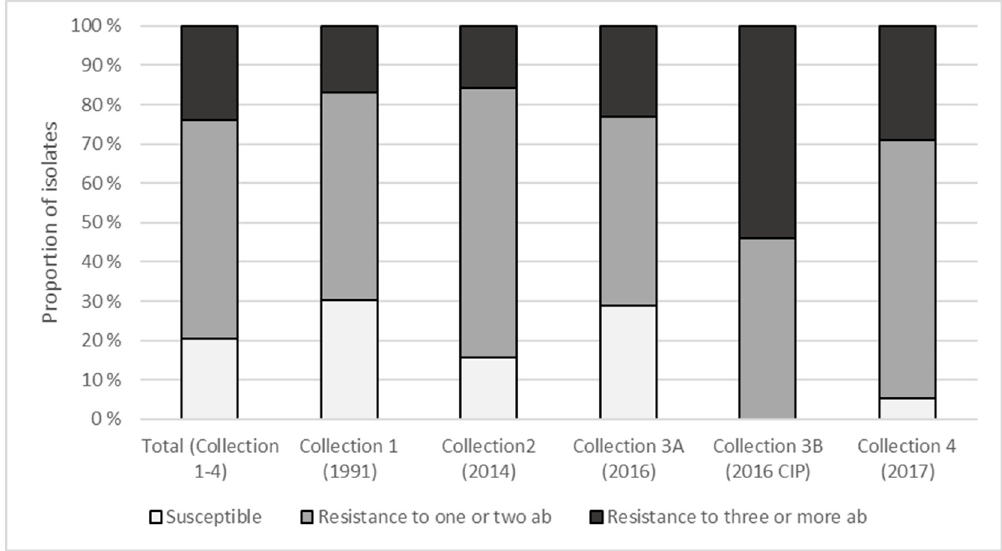
Figure 2. Proportion of antibiotic-susceptible and resistant isolates (total numbers n = 175) for all collections. See Table 2 for the 12 antibiotics tested.